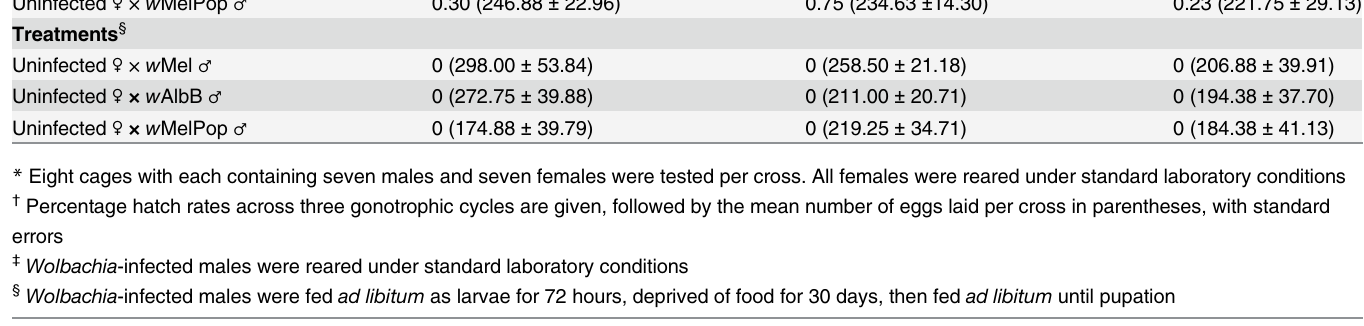
* Eight cages with each containing seven males and seven females were tested per cross. All females were reared under standard laboratory conditions † Percentage hatch rates across three gonotrophic cycles are given, followed by the mean number of eggs laid per cross in parentheses, with standard errors ‡ Wolbachia -infected males were reared under standard laboratory conditions